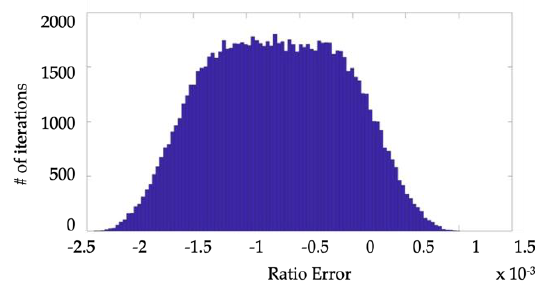
Figure 4. PDF of the ratio error calculated from the nominal accuracy specifications of the items.